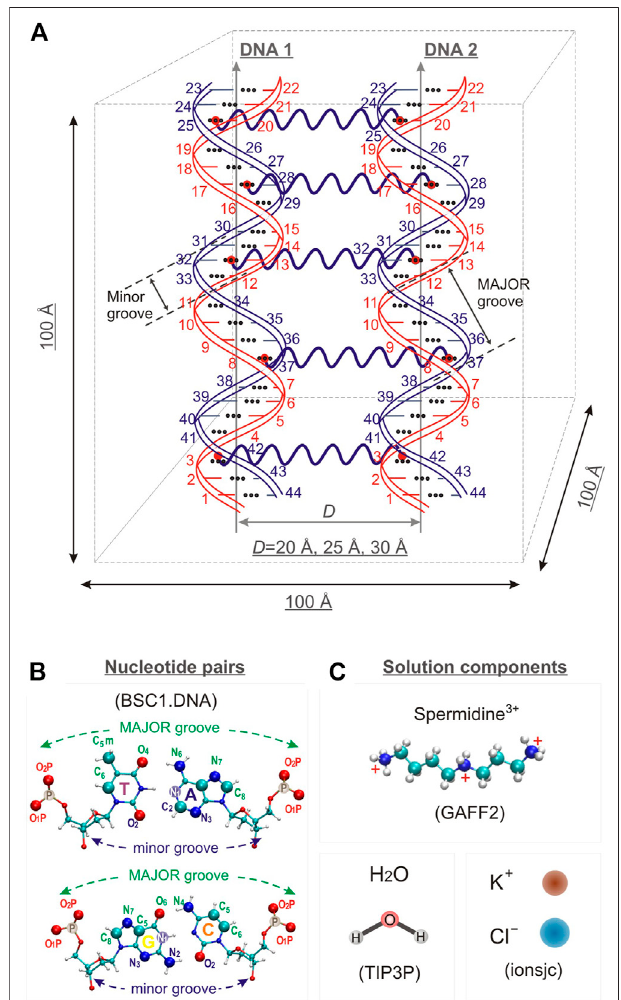
FIGURE 1 | (A) Schematic representation of the simulation box for systems DD-20 Å, DD-25 Å, DD-30 Å, together with the numbering of the nucleotide bases, and the indication ofthe positioning ofthe restraints used in the simulation to maintain the initial relative orientation and distance between the DNA helices. (B) T-A and C-G base pairs with the label of the atoms used as reference in the analysis. (C) . Schematic representation of the structure of the solvent and counter- and co-ions of DNA. The force fi elds used to describe the components are also